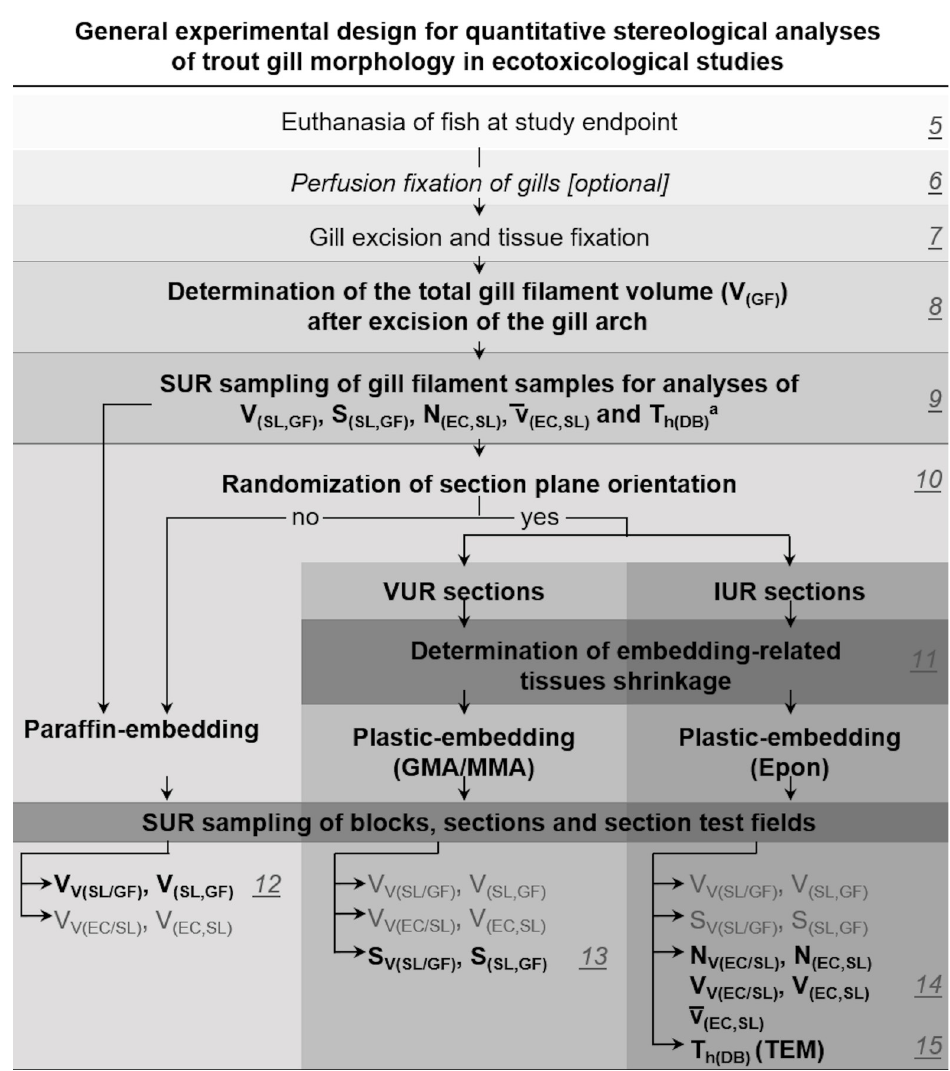
Fig 5. General experimental design for quantitative stereological analyses of trout gill morphology in ecotoxicological studies. The paper sections containing the respective sample processing and analysis steps are indicated (5–15). At the end point of the study, fish are euthanized, using a gill-preserving killing method ( Section 5 ). Optional perfusion fixation, excision-, fixation- and volumetry of gills after removal of the gill arch are described in Sections 6–8 . Section 9 presents the systematic uniform random (SUR) sampling of representative gill filament specimens for stereological analyses. a After SUR sampling of the specimens, it is strongly recommended to store the remaining fixed gills and not discard them until final completion of the study. The subsequent processing steps and analysis methods depend on the individual quantitative stereological parameters of interest ( Sections 10–15